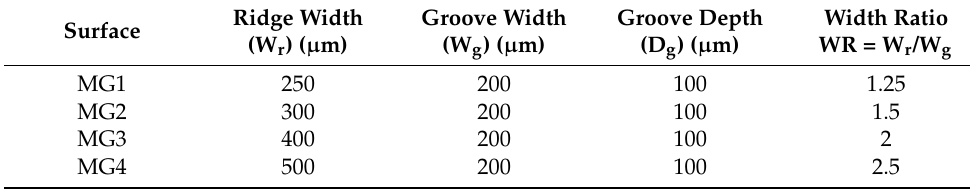
Figure 2. ( a ) Geometrical parameters of MG: ridge width (W r ), groove width (W g ) and groove depth (D g ). ( b ) SEM image of MG1 and ( c ) optical microscope image of a ridge surface of MG1. Table 1. Nomenclature and geometrical parameters of